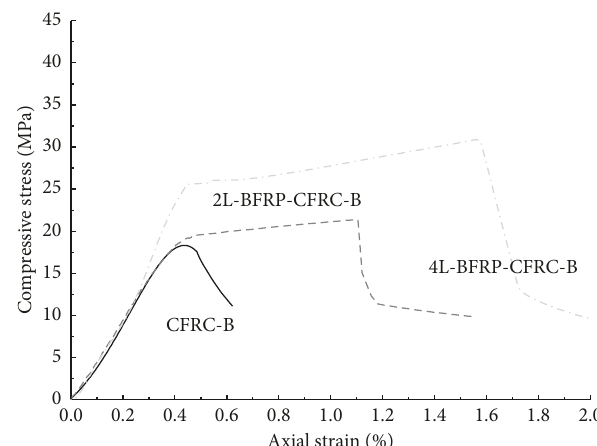
Figure 7: Effect of BFRP layers on the axial stress-strain behavior of the 160 ∗ 320mm